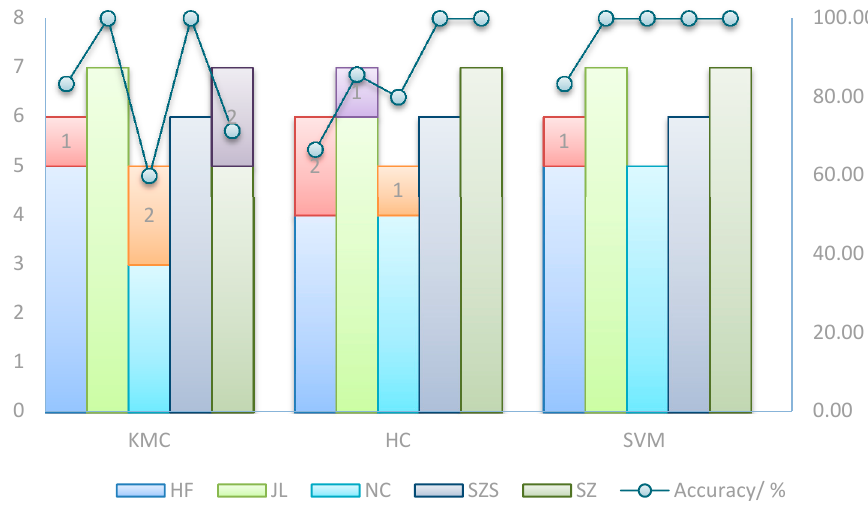
Figure 7. Classification of all grain samples with different chemometric methods. The number marked in the pillar was the misclassification sample number. The polyline shows the classification accuracy of each method for samples in different geographical origin.